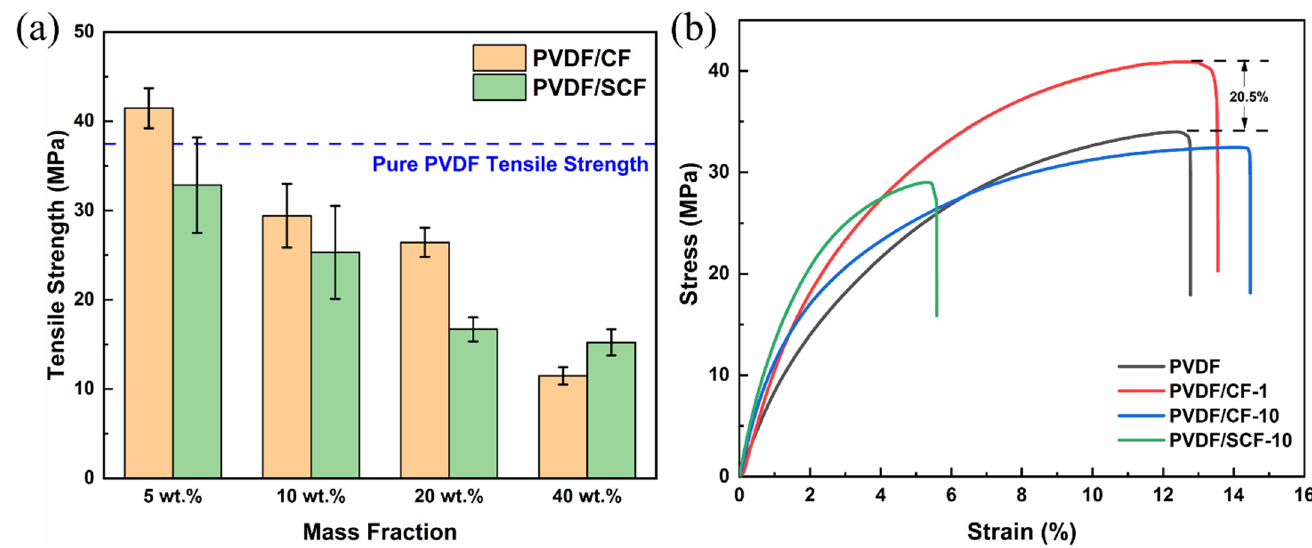
Figure 10. Mechanical properties of the pure PVDF and the PVDF composites: ( a ) tensile strength, ( b ) stress–strain curves.